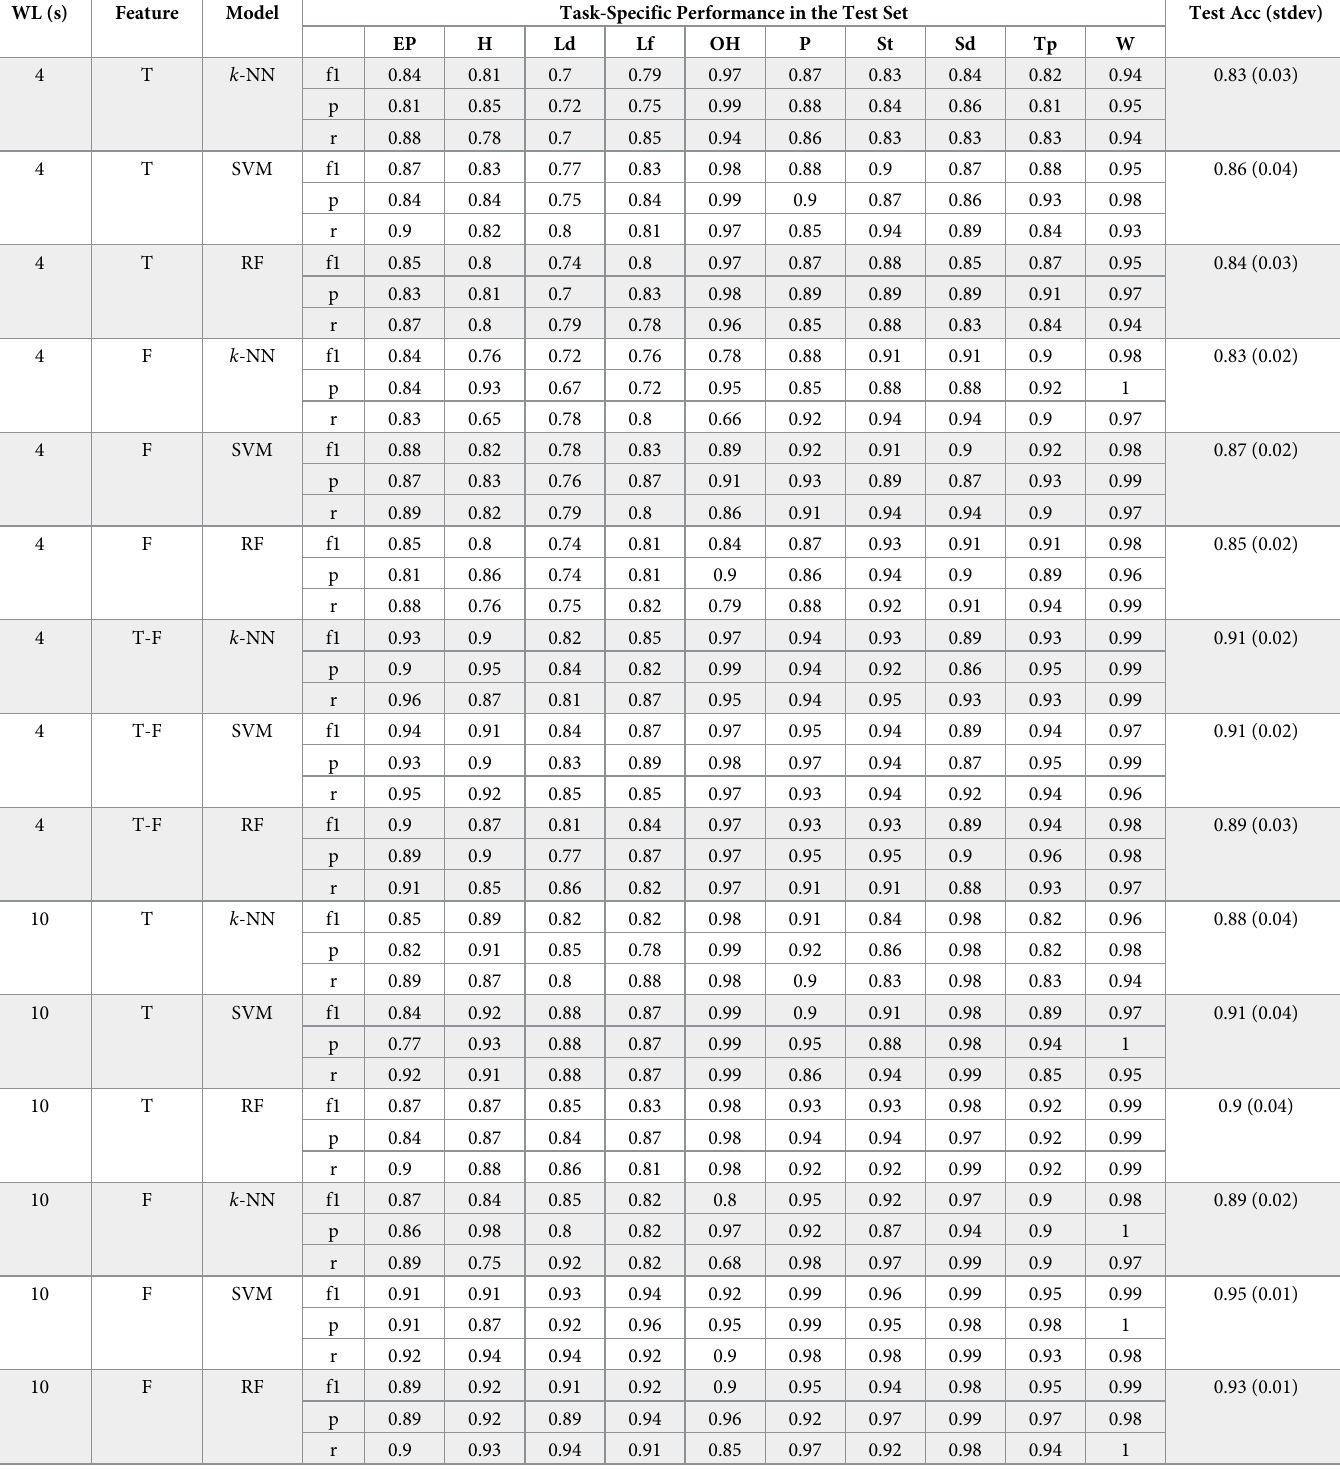
Table 5. Inter-subject classification performance. Abbreviations: WL: window length, T: time, F: frequency EP: electrical panel, H: hoisting, Ld: ladder, Lf: lifting; OH: overhead; P: pushing; St: sitting; Sd: standing; Tp: typing; W: walking. WL (s)